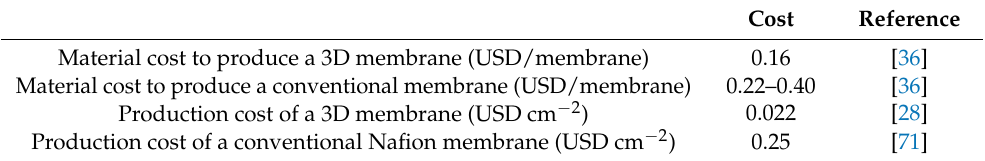
Table 3. Cost comparison of 3D and conventional membranes for microbial fuel cell.